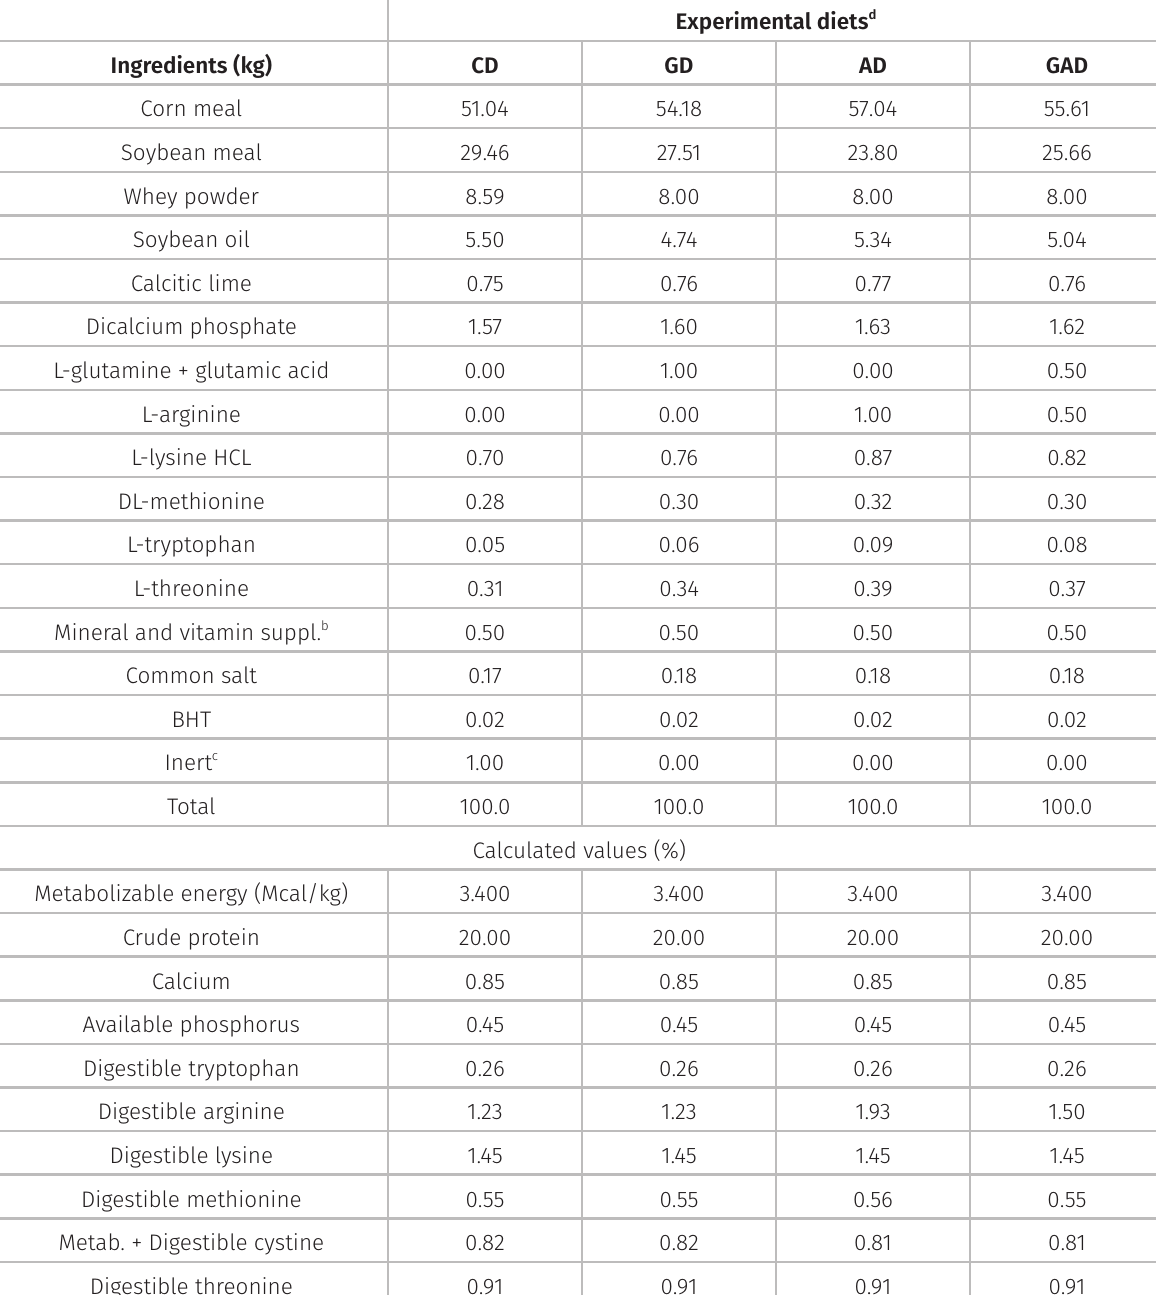
Table I. Formulation and chemical composition of experimental diets used for piglets weighing 5-9 kg a .